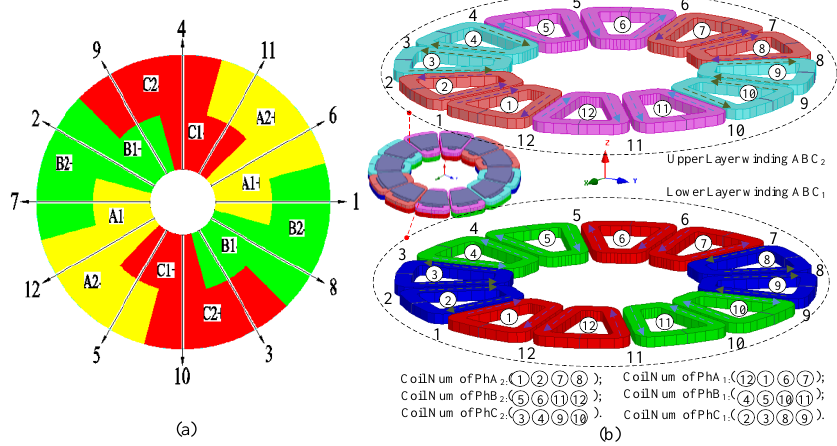
6 of 21 Figure 8. Resultant winding MMF of 12-slot/10-pole TP-FL winding at time t = 1.67 × 10 −3 s. Similarly, for a 12-slot/10-pole TP-FL winding, resultant winding MMFs F ( θ , t ) are given by winding function method as shown in Figure 9. Figure 9. For 12-slot/10-pole TP-FL winding, resultant winding MMF changes with time and space. 2.3. DTP-FL Winding Function